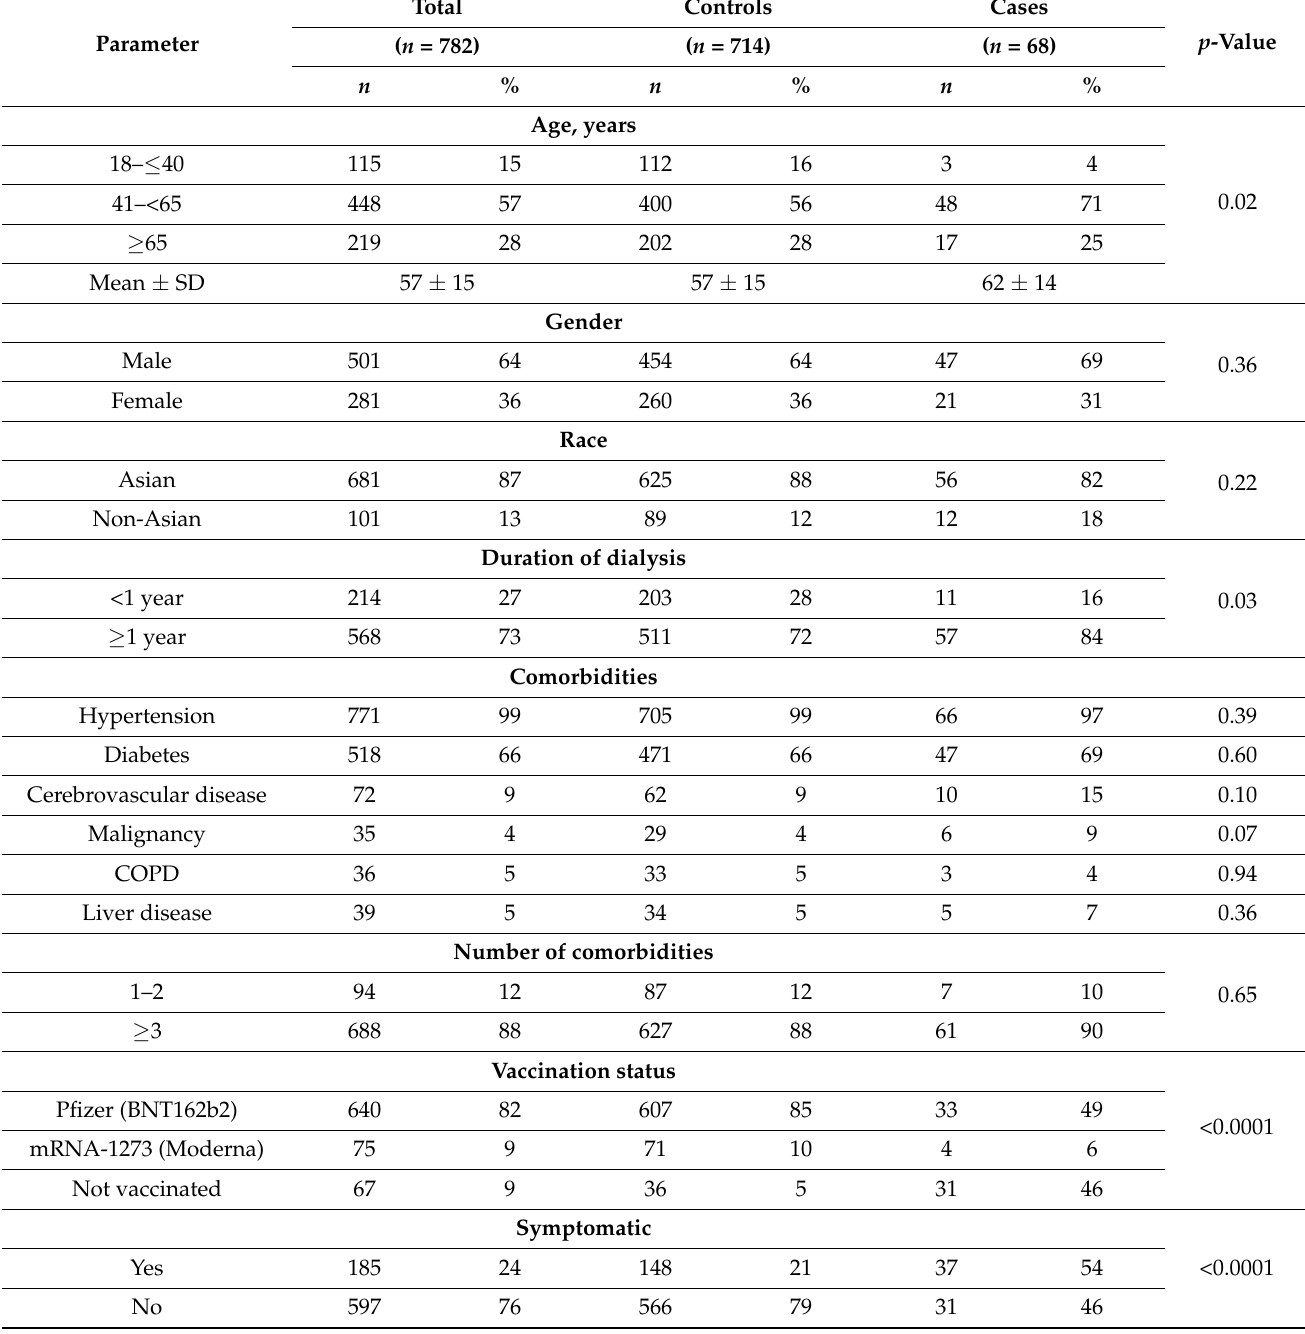
Table 1. Baseline characteristics of cases and